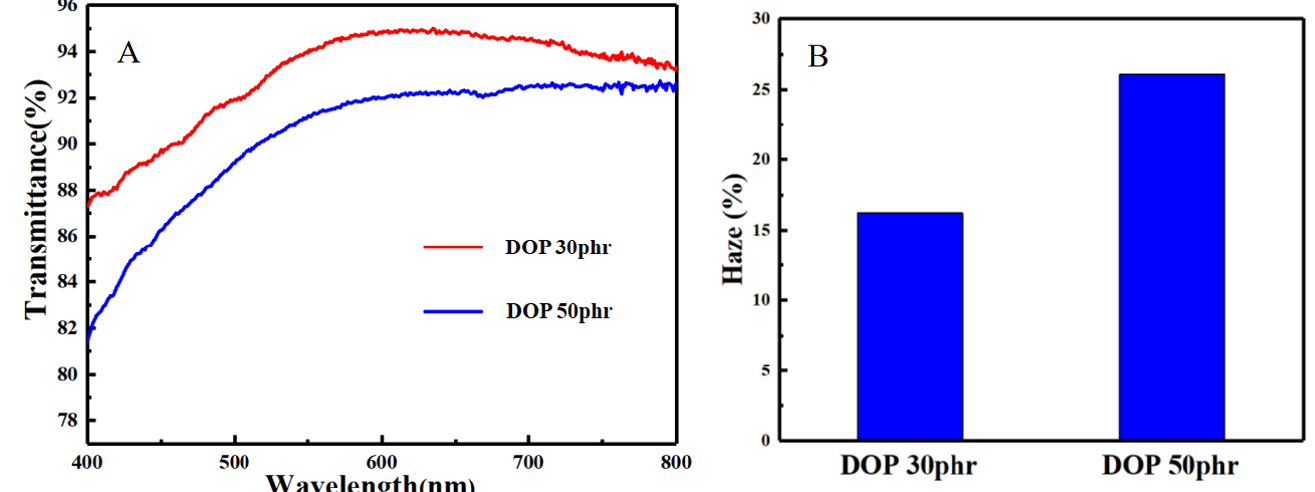
Figure 2. The transmittance ( A ) and haze ( B ) of PVC with different content of